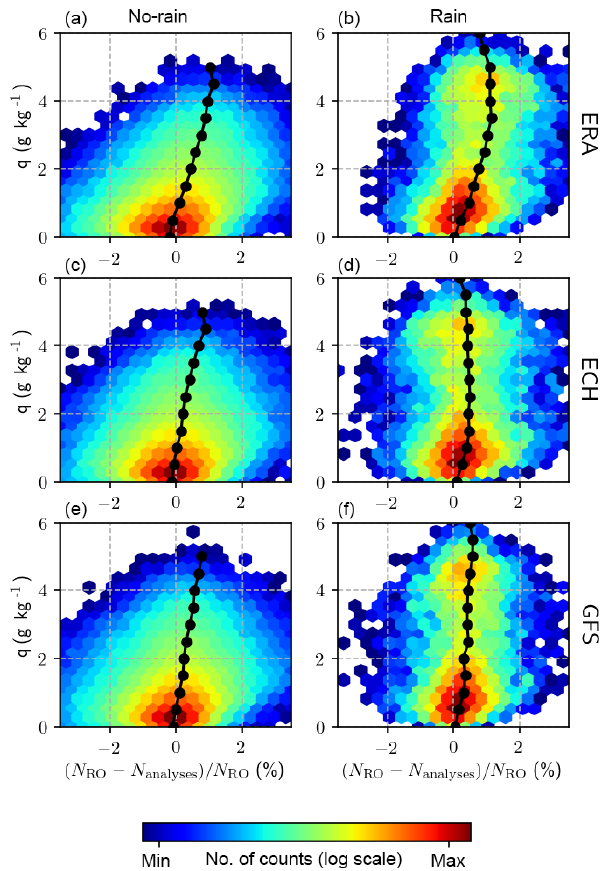
Figure 5. Fractional refractivity difference between the observa- tions and analyses as a function of the observed specific humidity at a height of 6km. Panels (a) , (c) , (e) correspond to the no-rain cases, and panels (b) , (d) , (f) correspond to the rain cases. Pan- els (a) and (b) show the results for the comparison of observations and ERA-Interim, panels (c) and (d) show the results for ECMWF high-resolution analysis, and panels (e) and (f) show the results for the